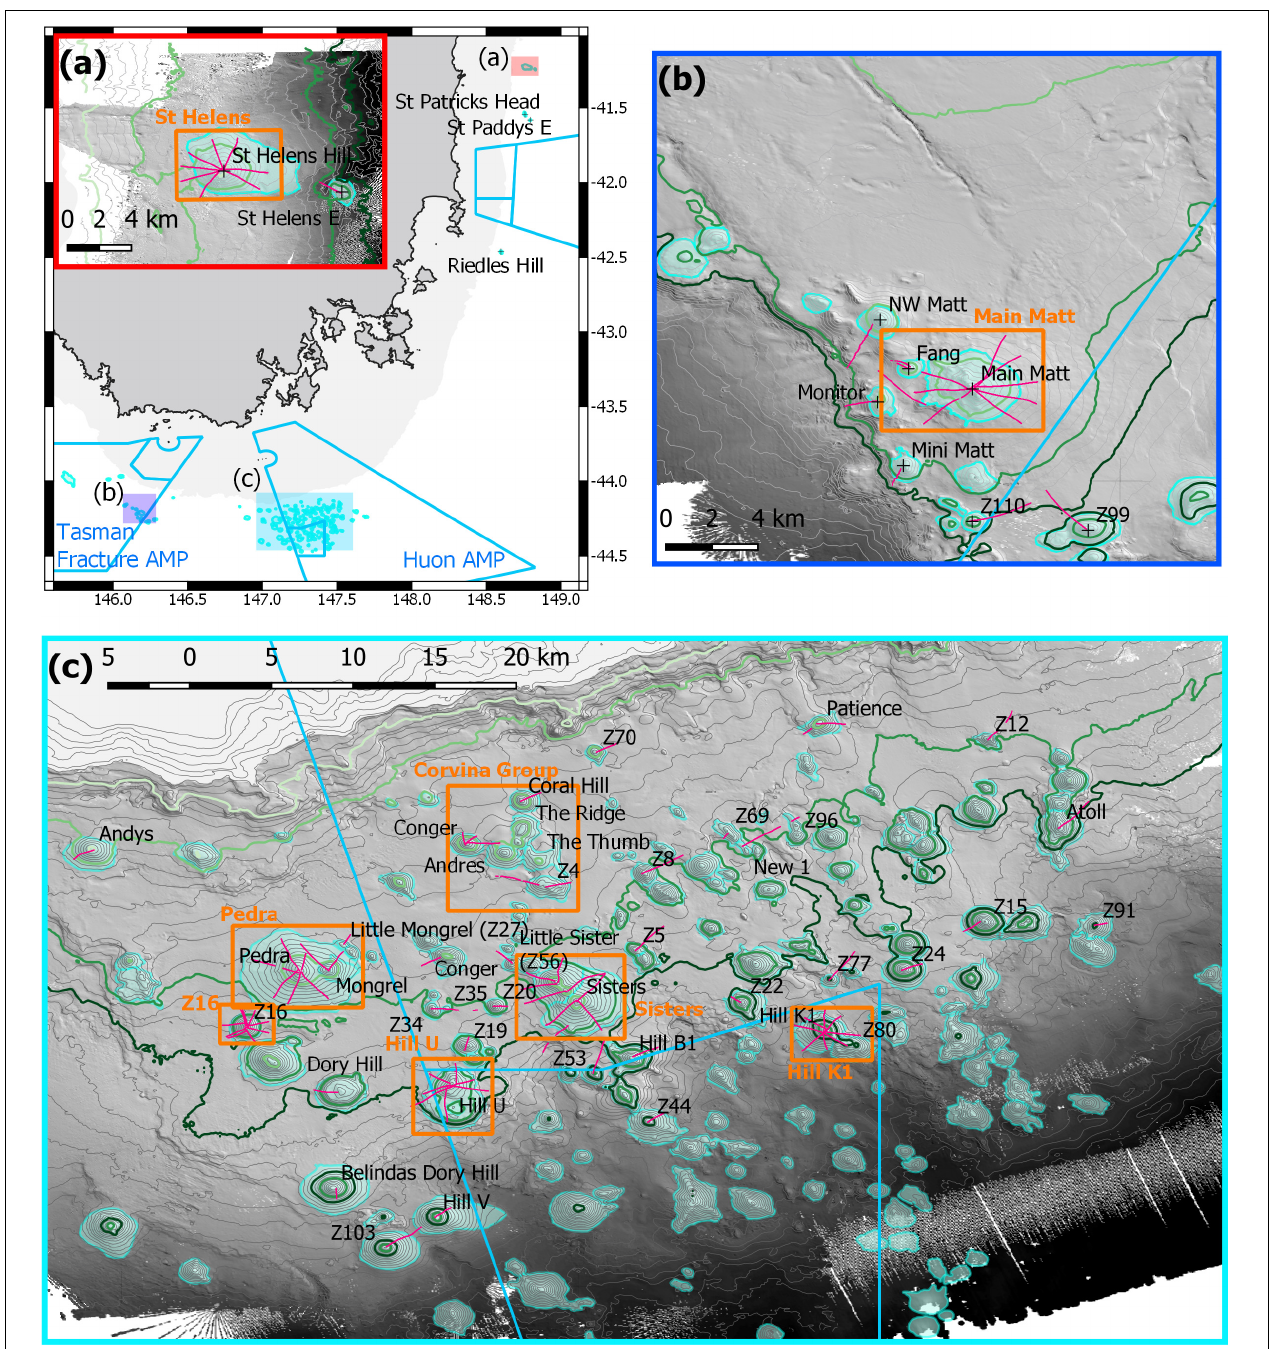
FIGURE 1 | Map of study area off eastern and southern Tasmania, Australia, showing locations and names of study sites, camera transects (pink lines), eight Focal areas with relatively higher sampling intensity (orange boxes), and the Australian Marine Park (AMP) boundaries (light blue): (a) overview map showing the relative locations of the three study areas and a 0–500 m depths mask (grey), with inset showing sites at the St Helens Seamount and one adjacent seamount; (b) sites in and adjacent to the Tasman Fracture AMP; (c) sites in and adjacent to the Huon AMP. Depth contours are 50 m intervals with 650, 950, 1,350, and 1,500 m contour lines highlighted as light to dark green; the seamounts are outlined by their base boundaries (cyan).